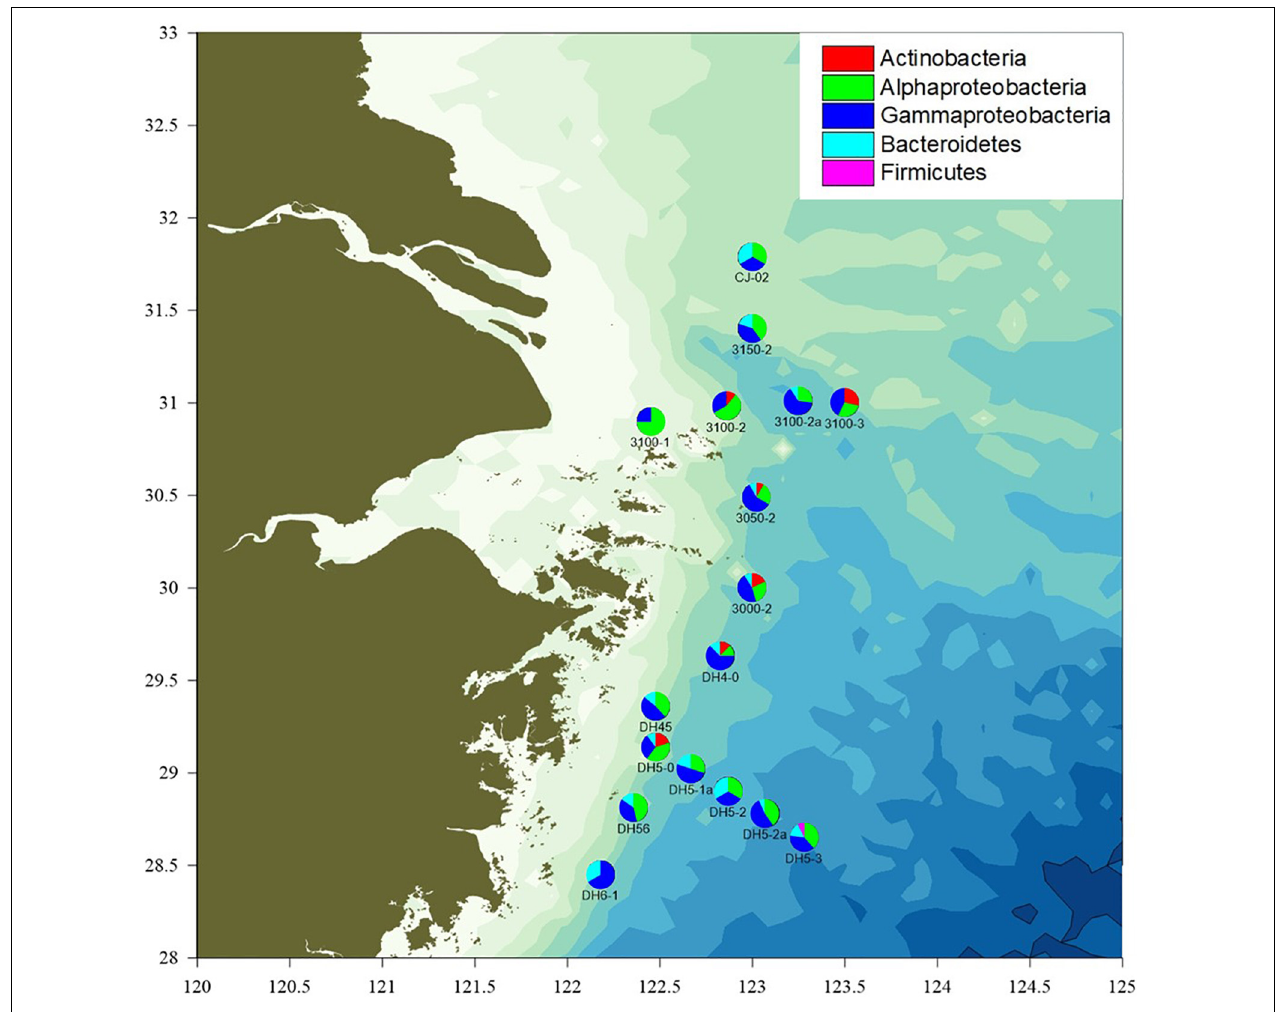
FIGURE 1 | The sampling locations and proportion of isolates classified to each phylum and (partly) class in the Changjiang River Estuary